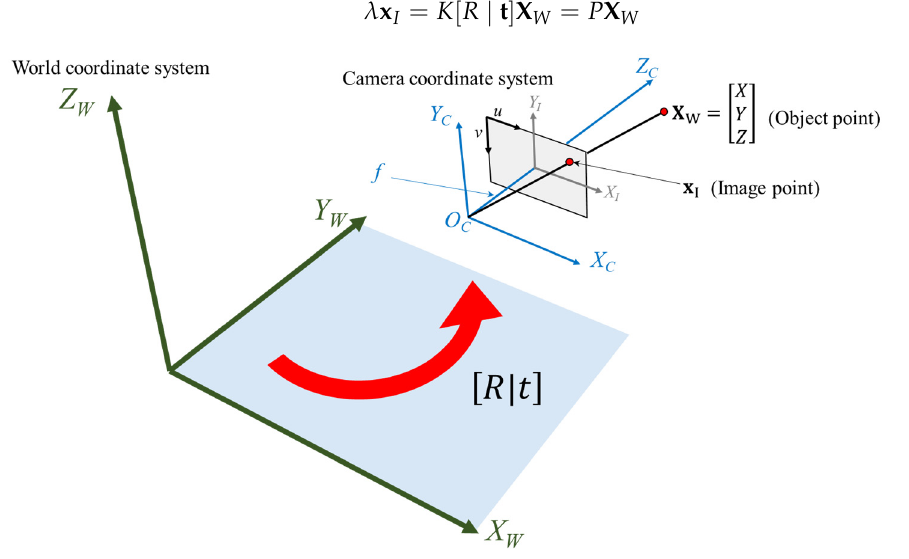
Figure 1. World coordinate system and perspective projection camera coordinate system.